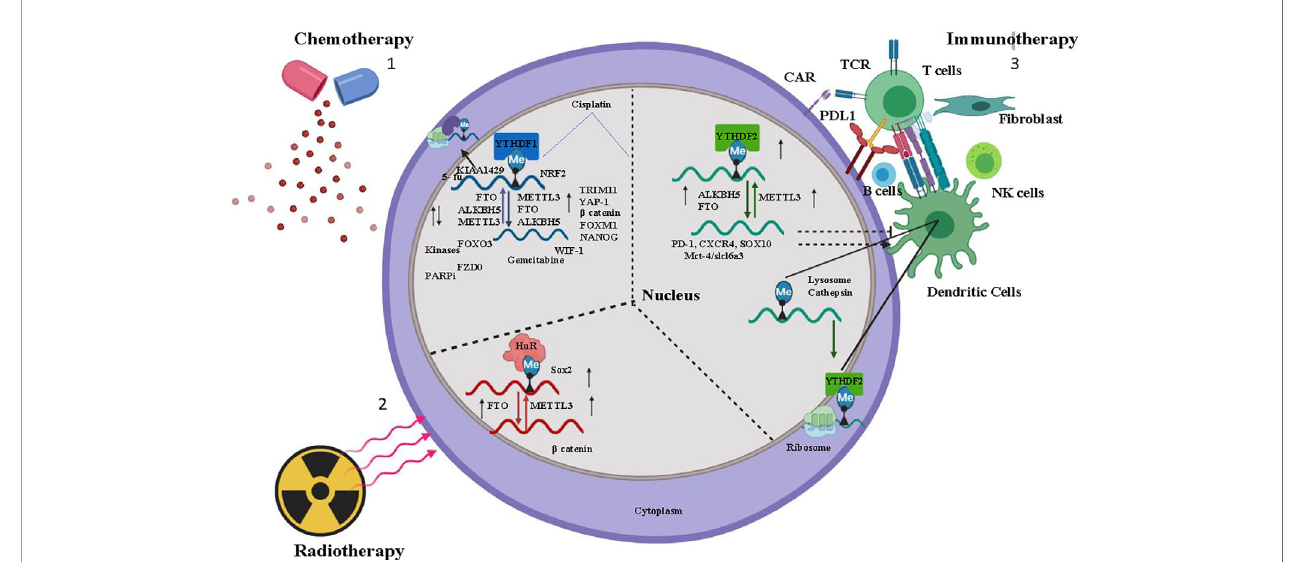
FIGURE 1 | Overview of m6A regulation in Chemotherapy, Immunotherapy, and Radiotherapy- 1) Chemotherapeutic drugs Cisplatin, Kinase inhibitor modulates m6A regulator (Writer-METTL3, Raeder-YTHDF1, Eraser-ALKBH5, FTO) stabilizes the oncogene mRNA and induces chemoresistance. 2) Tumor immuno microenvironment (TIME) (B cells, dendritic cells, T cells, NK cells, fi broblast) activated by m6A regulator and induces immunotherapy resistance for cancer cells. 3) Radiation induces m6a regulator and stabilizes mRNA of cancer stem cell. In the fi gure, the small upward black arrow indicates “ upregulation ” and the downward black arrow indicates “ down regulation ”